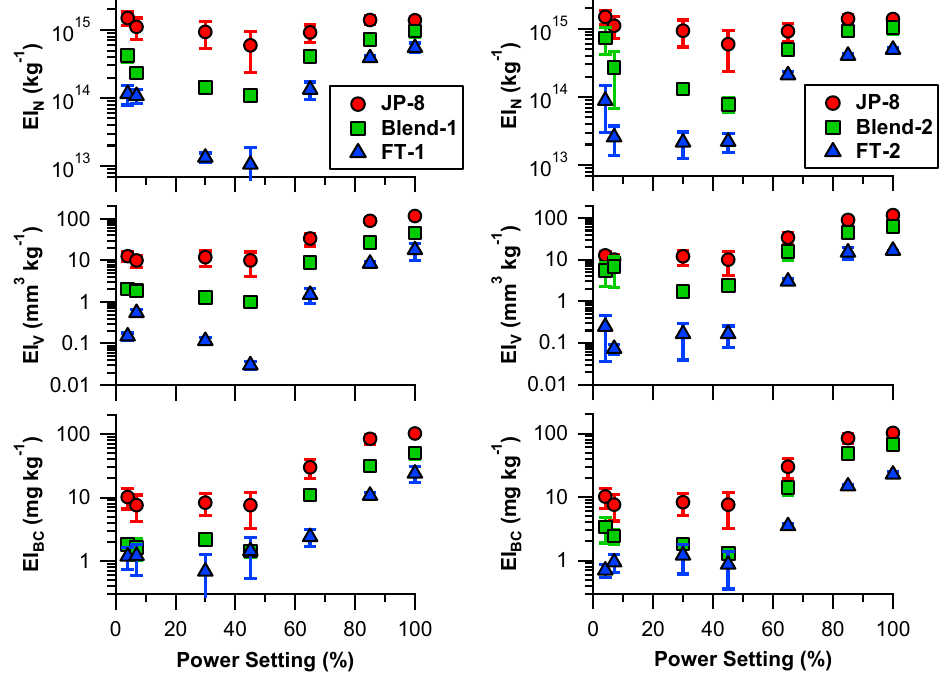
Fig. 3. Aerosol emission indices 1m behind the #3 engine when fueled with JP-8, blended fuels, and pure FT fuels for FT-1 (left) and FT-2 (right). One-sigma standard deviations are shown as error bars (at high power, standard deviations were often below the figure resolution – typically